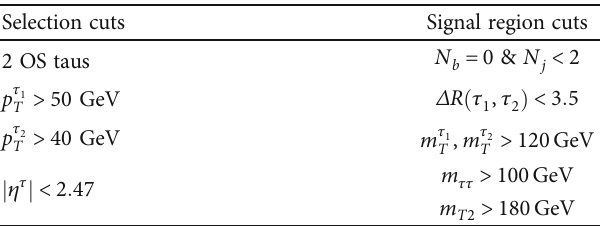
ffiffi p = 14 TeV s